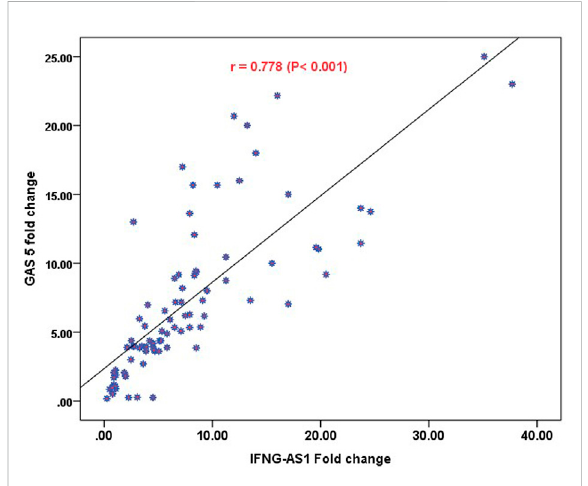
FIGURE 2 Pearson correlation analysis of the expression of IFNG-AS1 and GAS5 . A strong signi fi cant positive correlation was detected between IFNG-AS1 and GAS5 ( r = 0.778, p < 0.001 ).